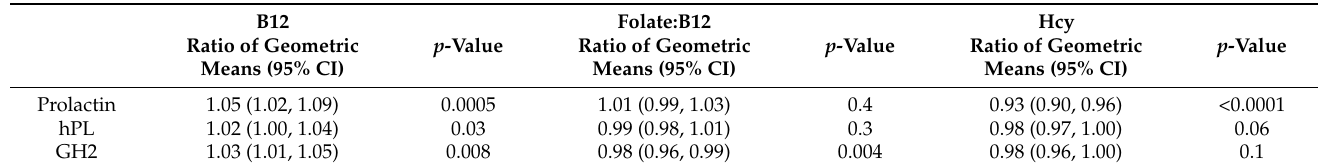
Table 4. Effects of B12, Folate:B12 and Hcy on serum hormones concentrations in SCOPE (14–16 weeks of gestation) and STOP (6–16 weeks) women combined. Effect for every 100 unit increase in B12 and Folate:B12, and for every 1 unit increase in